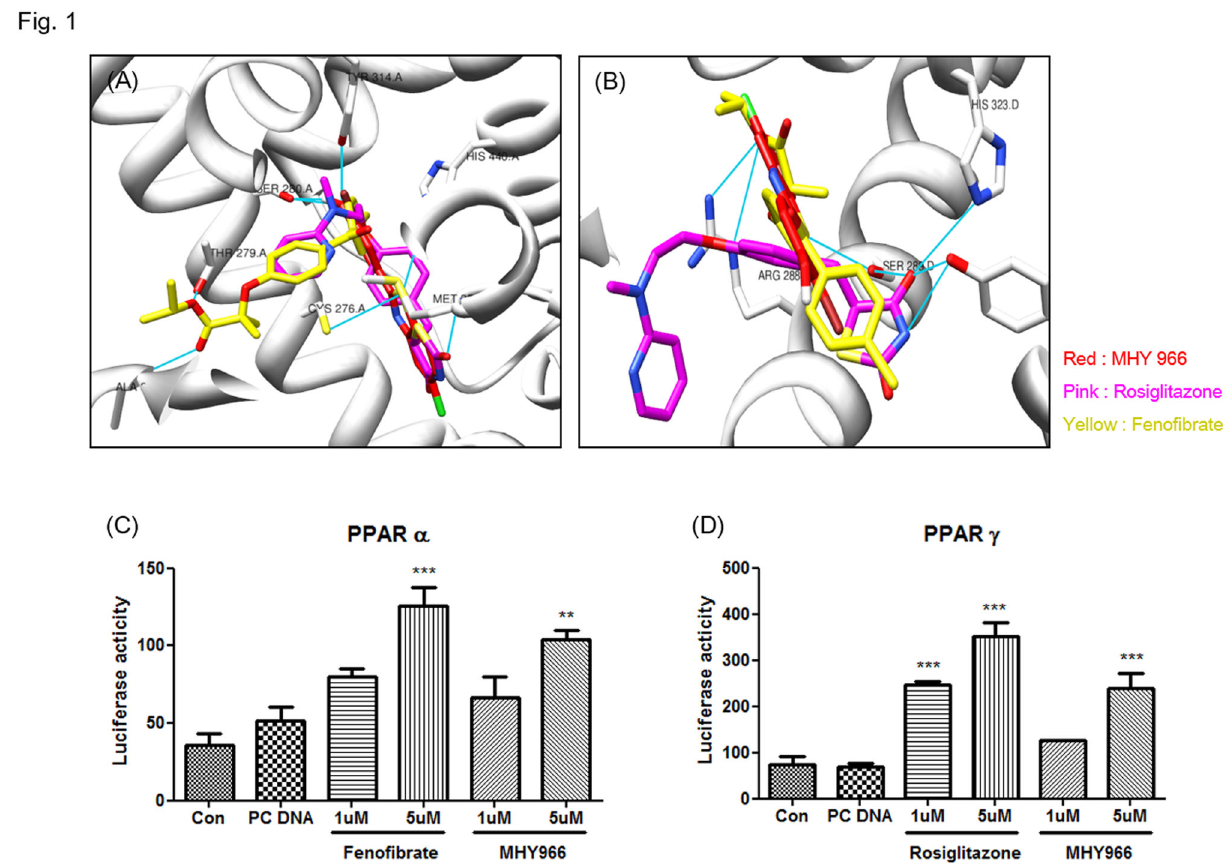
Figure 1. MHY 966 functioned as a PPAR α/γ dual agonist. (A) and (B), Docking simulation was performed to identify interaction between LBD and MHY 966. Docking modes of MHY 966 on the LBD of human PPAR α and γ. MHY 966 has similar binding sites compared with known PPAR α and γ agonist, fenofibrate and rosiglitazone, respectively. For luciferase assay, AC2F cells overexpressing PPAR α (C) and PPAR γ (D) were treated with 1 or 5 μM fenofibrate, rosiglitazone, or MHY 966 for 6 h. Bars represents means ± SEMs of triplicates results. *** P < 0.001, ** P < 0.01 and * P < 0.05 versus cell treated with PC DNA group. C and D,